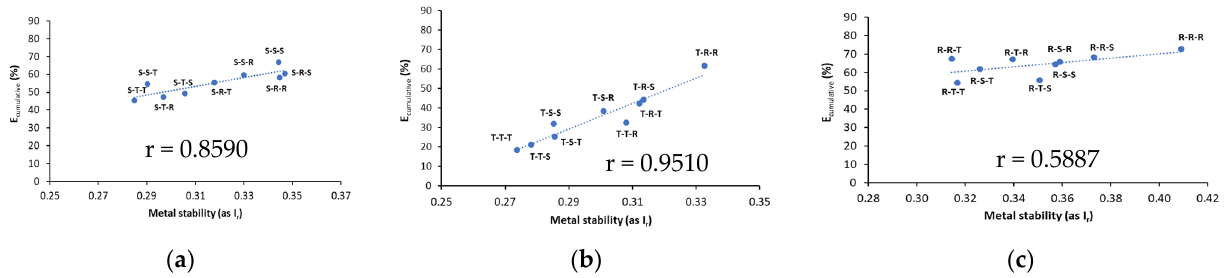
Figure 7. A relationship between cumulative Pb removal efficiency (E cumulative ) and stability of residual Pb in washed soil (I r ) for different biosurfactant variants: ( a ) saponin variant, ( b ) tannic acid variant, ( c ) rhamnolipids variant.